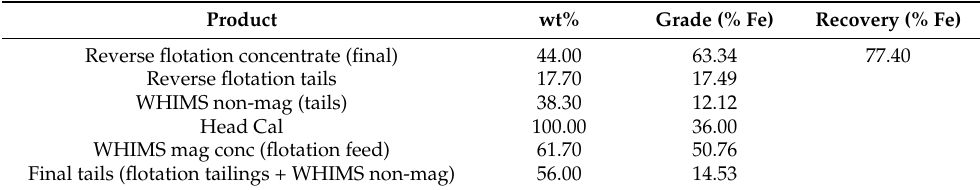
Table 10. Final test with WHIMS followed by flotation of WHIMS concentrate.